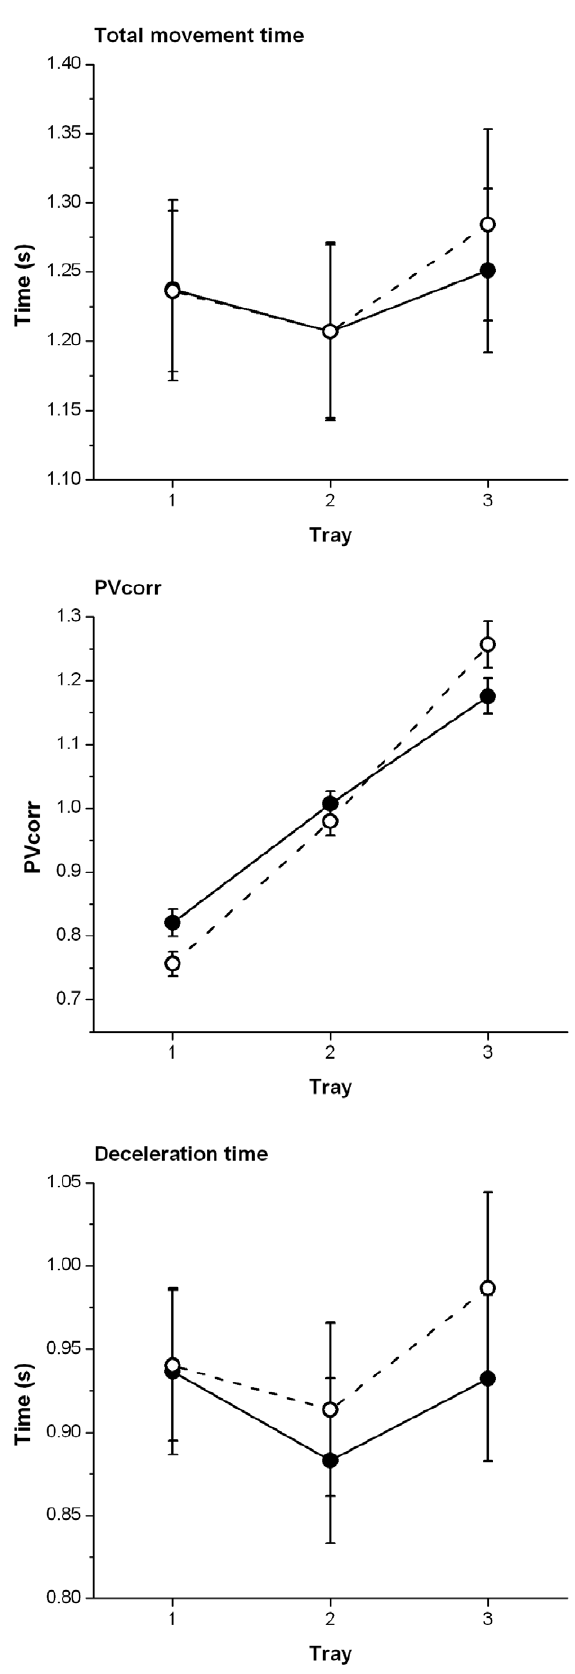
Figure 4. Significant group 6 tray interactions. These plots show the dependent variables where significant group 6 tray interactions were identified. For each plot the solid circles and solid line represent the young adults and the open circles and dotted line represent the older adults. Circles show the mean and error bars the standard